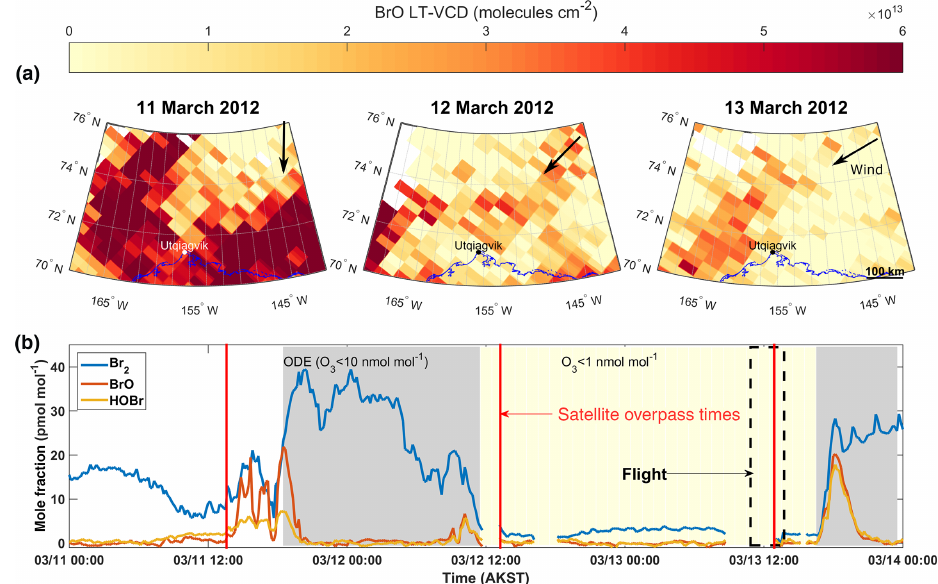
Figure 3. Summary of (a) satellite-based BrO observations over northern Alaska and (b) ground-based reactive bromine measurements at the Utqia˙gvik tundra site. (a) BrO lower-tropospheric vertical column densities (LT-VCDs) from the GOME-2 satellite are shown from 11 to 13 March 2012, with the location of Utqia˙gvik, Alaska, denoted. The top portion of the map is the Arctic Ocean, while the bottom portion is snow-covered tundra. The wind direction at Utqia˙gvik is shown with black arrows. (b) Gas-phase bromine species (Br 2 , BrO, and HOBr) mole fractions measured with chemical ionization mass spectrometry are shown for 11–13 March 2012. Data gaps represent time periods of separate experiments (Pratt et al., 2013). Times when an ODE (O 3 < 10nmolmol − 1 ) was observed at Utqia˙gvik are shaded in gray; times when ozone was titrated (O 3 < 1nmolmol − 1 ) to the point of inhibiting BrO formation are shaded in yellow. The flight time is outlined with a black box, and the times of satellite overpasses are denoted with red